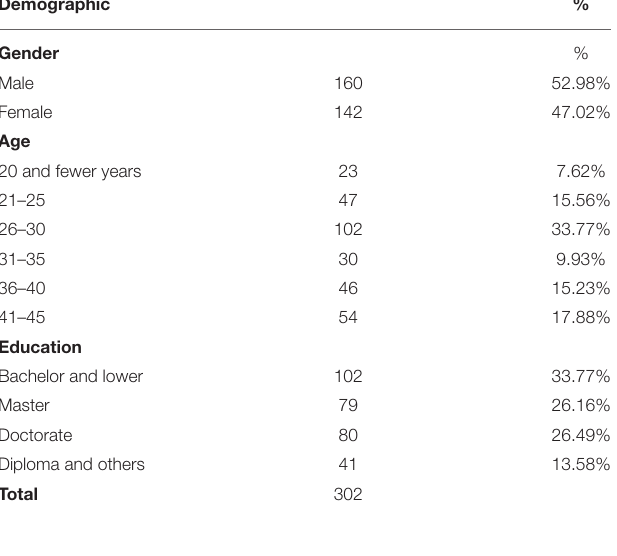
TABLE 1 | Demographics summary.